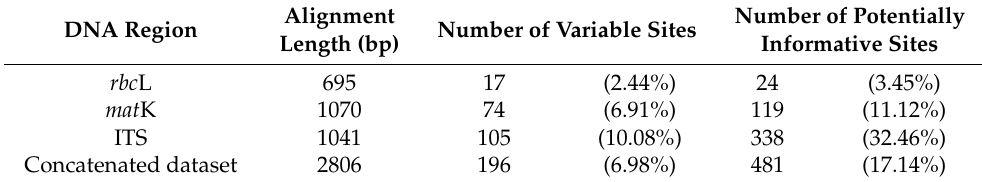
Table 2. Features of the DNA data sets used in this study (bp = base pairs). DNA Region